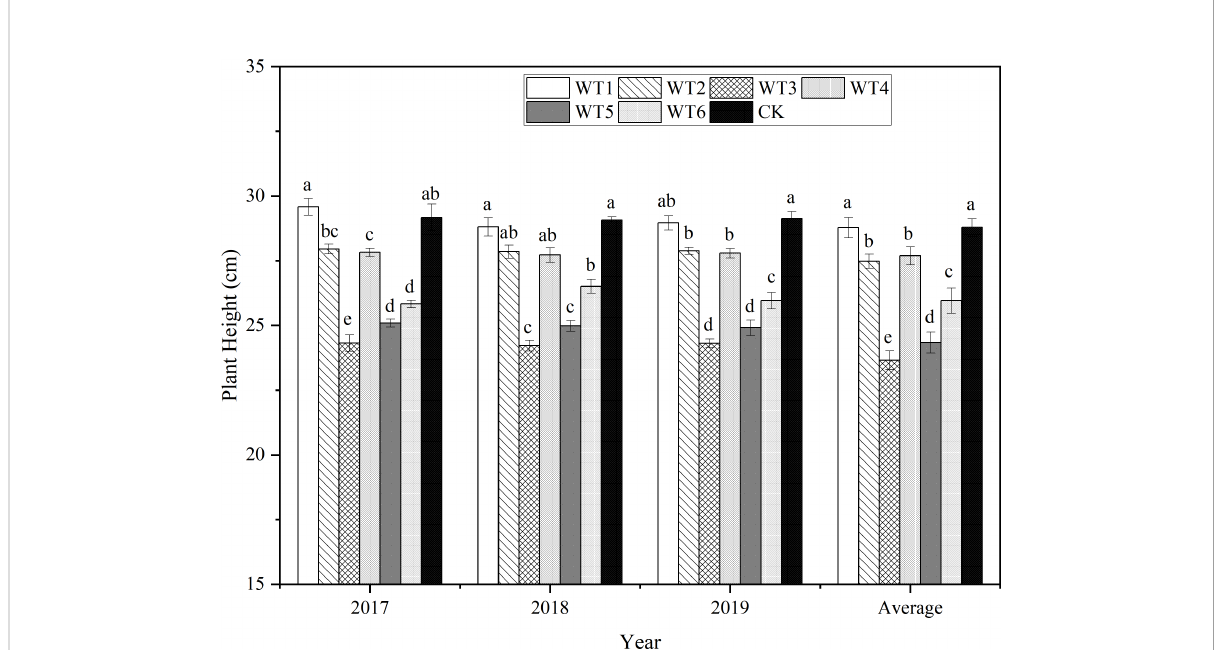
FIGURE 7 Final height of I. indigotica plants in different water de fi cit treatments. Different lowercase letters in the same column indicate signi fi cant differences ( P < 0.05). Data were presented as mean ± SE (n =